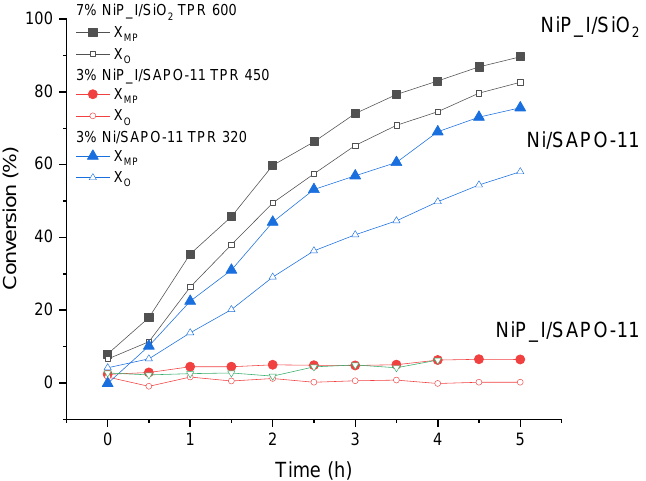
Figure 2. Conversion of MP and O-containing compounds over 7% NiP_I/SiO 2 , 3% Ni/SAPO-11, and 3% NiP_I/SAPO-11 catalysts in an autoclave (290 °C, 3 MPa, V H2 = 100 mL/min, 500 RPM, m cat = 1 g).